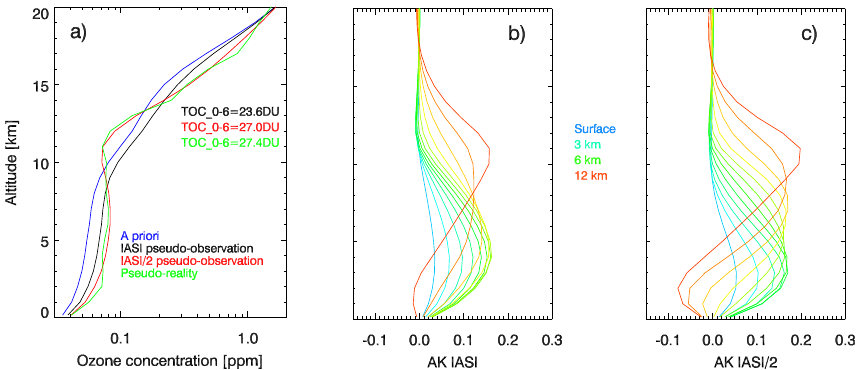
Fig. 12. MOCAGE pseudo-reality (green), IASI (black) and IASI/2 pseudo-observations (red) and a priori tropospheric profiles (blue) for the ozone peak of the 24 August in Paris ( a ); AKs from surface (sky blue) to 12km (red) for IASI and IASI/2 ( b , c ) for the same scenario